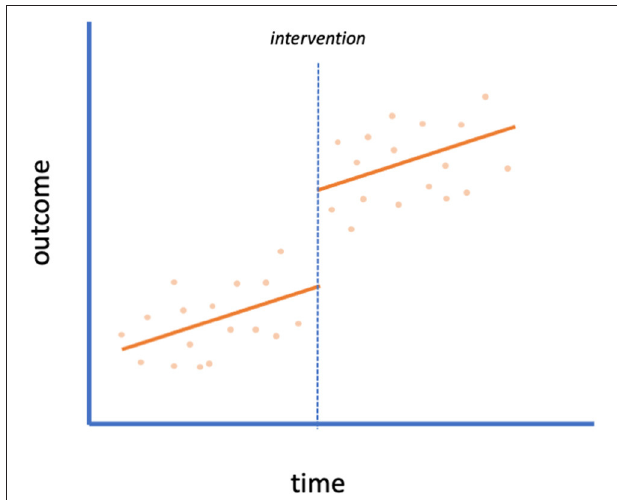
FIGURE 1 | Interrupted time series. An example of an interrupted time series design with no control group. A scatterplot of data is shown with the intervention implemented at the time of the dotted line. This plot indicates a level change (but no slope change) due to the intervention.